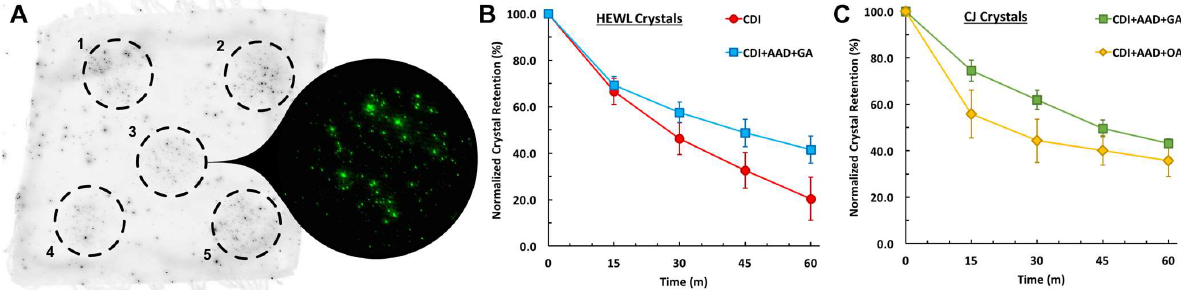
Figure 3. Results of the accelerated wash tests. ( A ) Cotton test swatch containing five areas of HEWL crystal attachment at time zero in the accelerated wash protocol. Inset: Magnified view of the center application area demonstrating the fluorescent puncta used to normalize the percent retention of protein crystals throughout the wash cycles. ( B ) Comparison of the short-length and long-length attachment reaction schemes for the HEWL crystals over 60 min of accelerated laundering time. Error Bars: standard deviation, n = 5. ( C ) Comparison of GA and OA cross-linked CJ-LPC retention over 60 min of accelerated laundering time. Error Bars: standard deviation, n = 5.